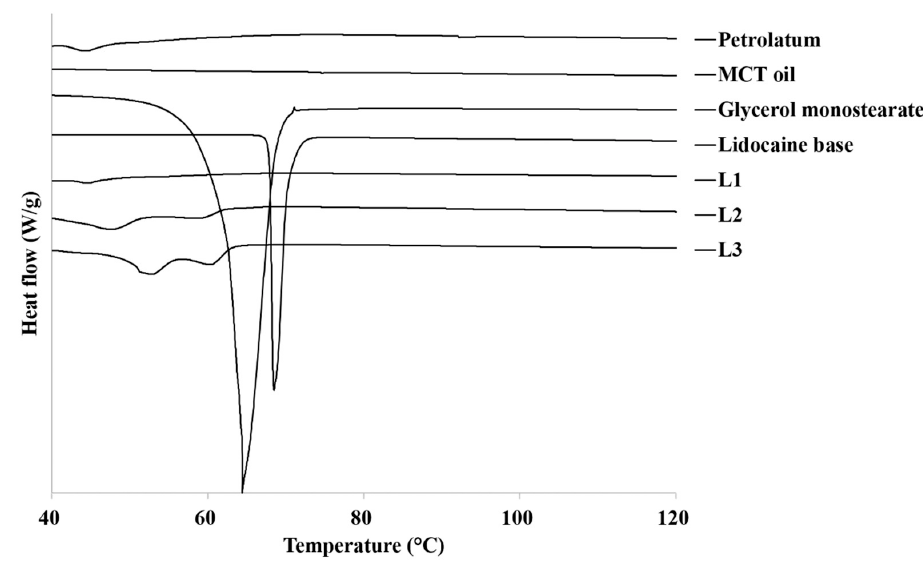
Figure 1. DSC thermograms of raw materials and prepared lidocaine ointments. MCT, medium- chain triglyceride. legend. The correct Figure 2 appears below.